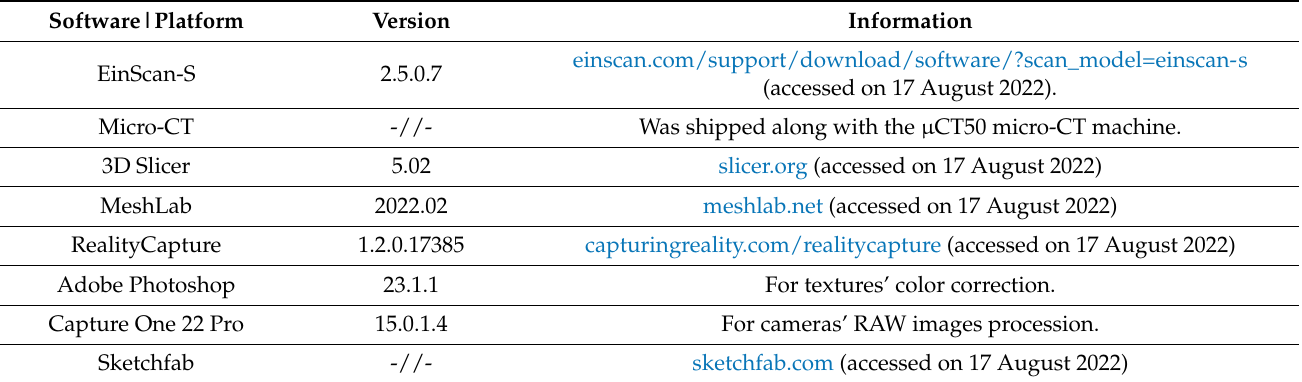
Table 2. The list of software